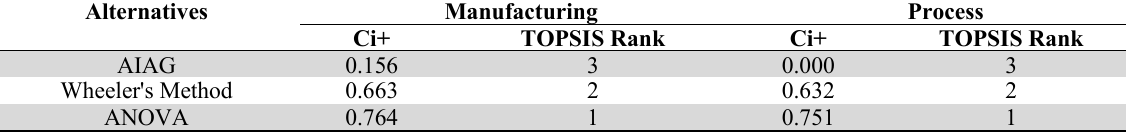
TOPSIS Ranks for Manufacturing and Process